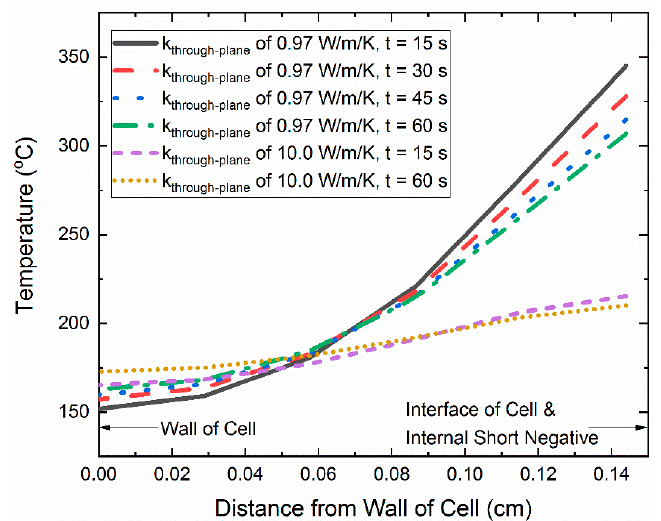
Figure 9. Modeling predicted temperature distributions in through-plane direction with through-plane thermal conductivities of 0.97 W/m/K and 10.0 W/m/K.